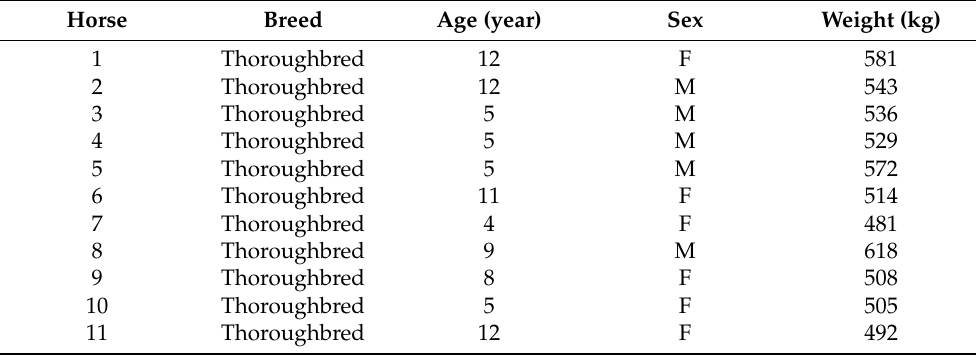
Table 1. Study population signalment and weight.